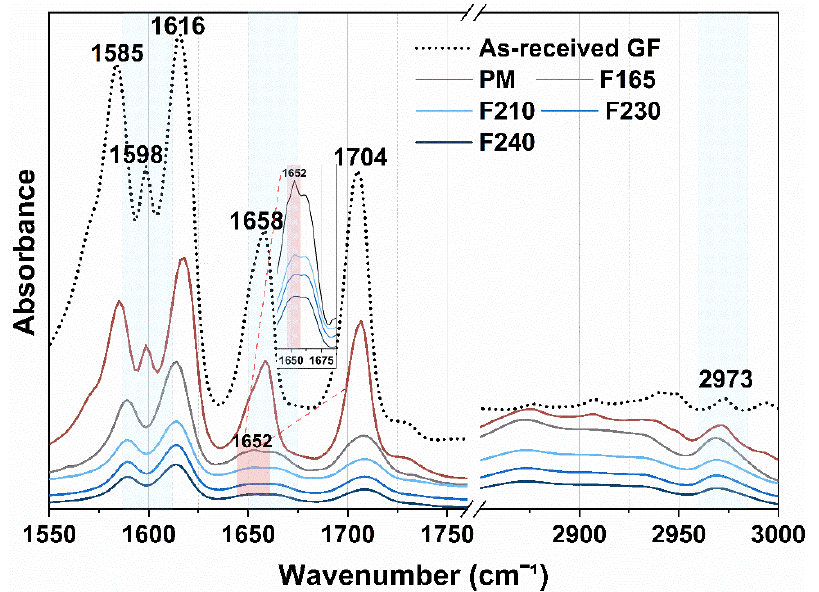
Figure 2. FT-IR spectra of as-received GF, physical mixture (PM) and 3D printed tablets through F165-F240.